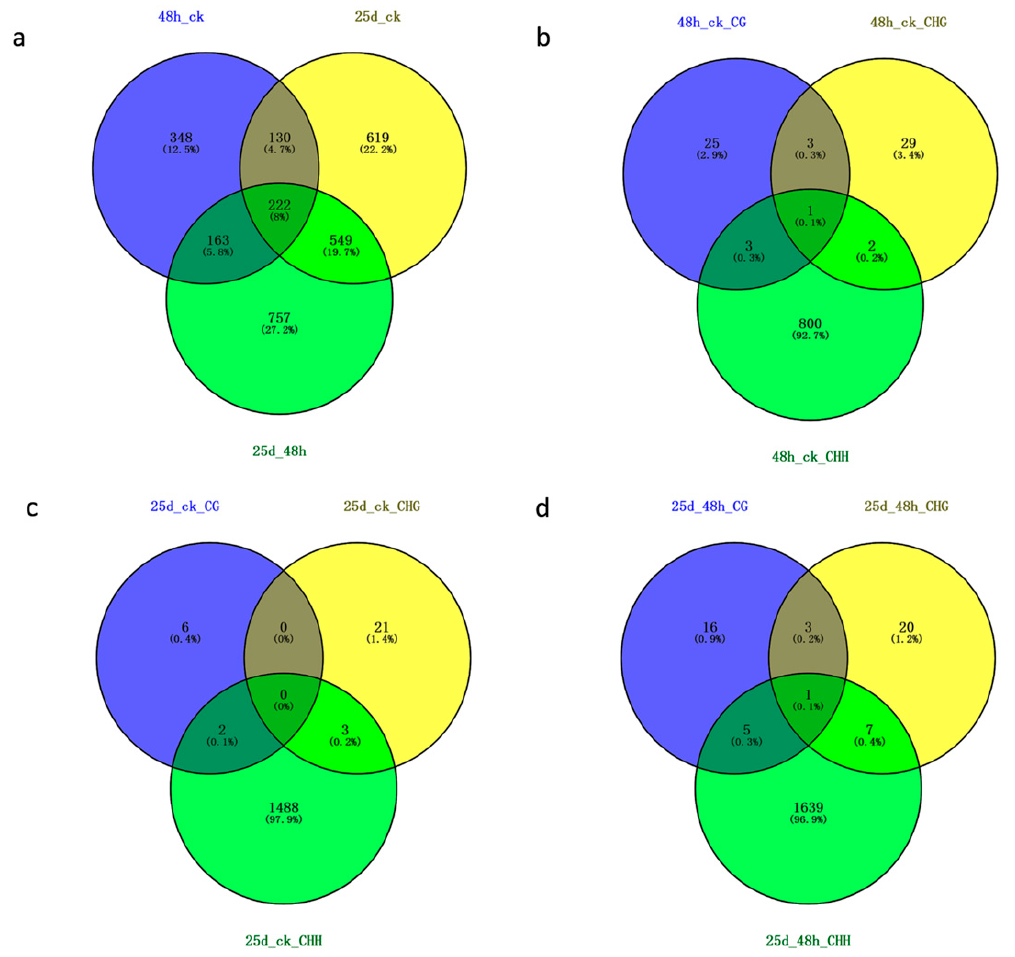
Figure 8. Venn diagram of DMR-associated genes (DMGs) among three libraries. ( a ) Venn diagram of DMGs among 48h_ck, 25d_ck, and 25d_48h; ( b ) Venn diagram of DMGs for 48h_ck under CG, CHG, and CHH contexts; ( c ) Venn diagram of DMGs for 25d_ck under CG, CHG, and CHH contexts; ( d ) Venn diagram of DMGs for 25d_48h under CG, CHG, and CHH contexts.